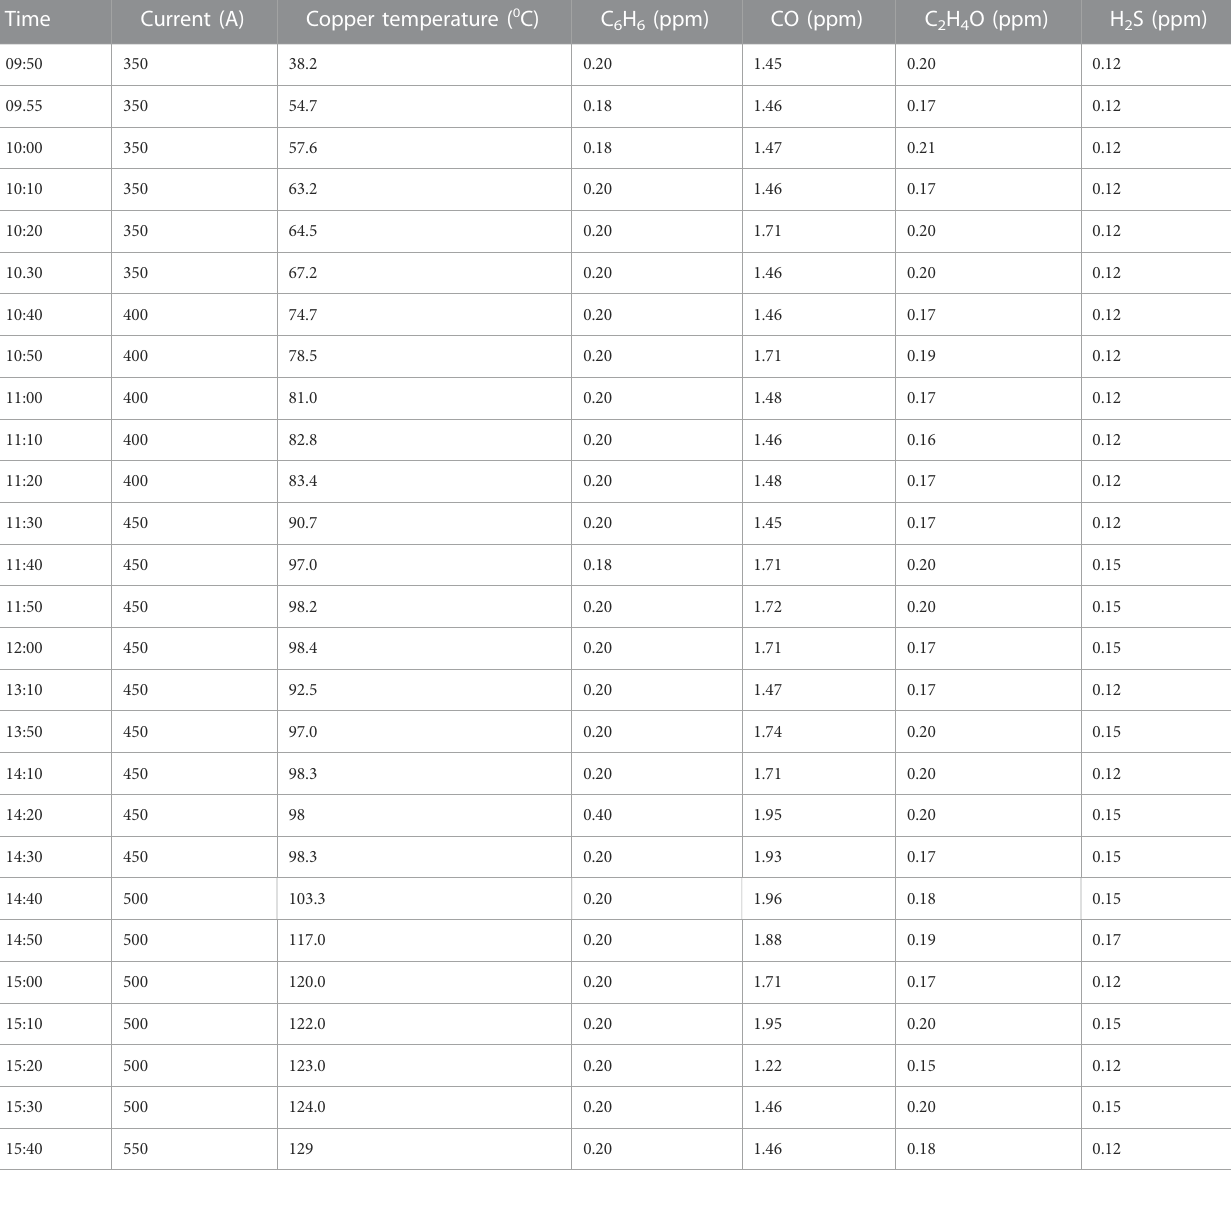
TABLE 1 Part of experiment